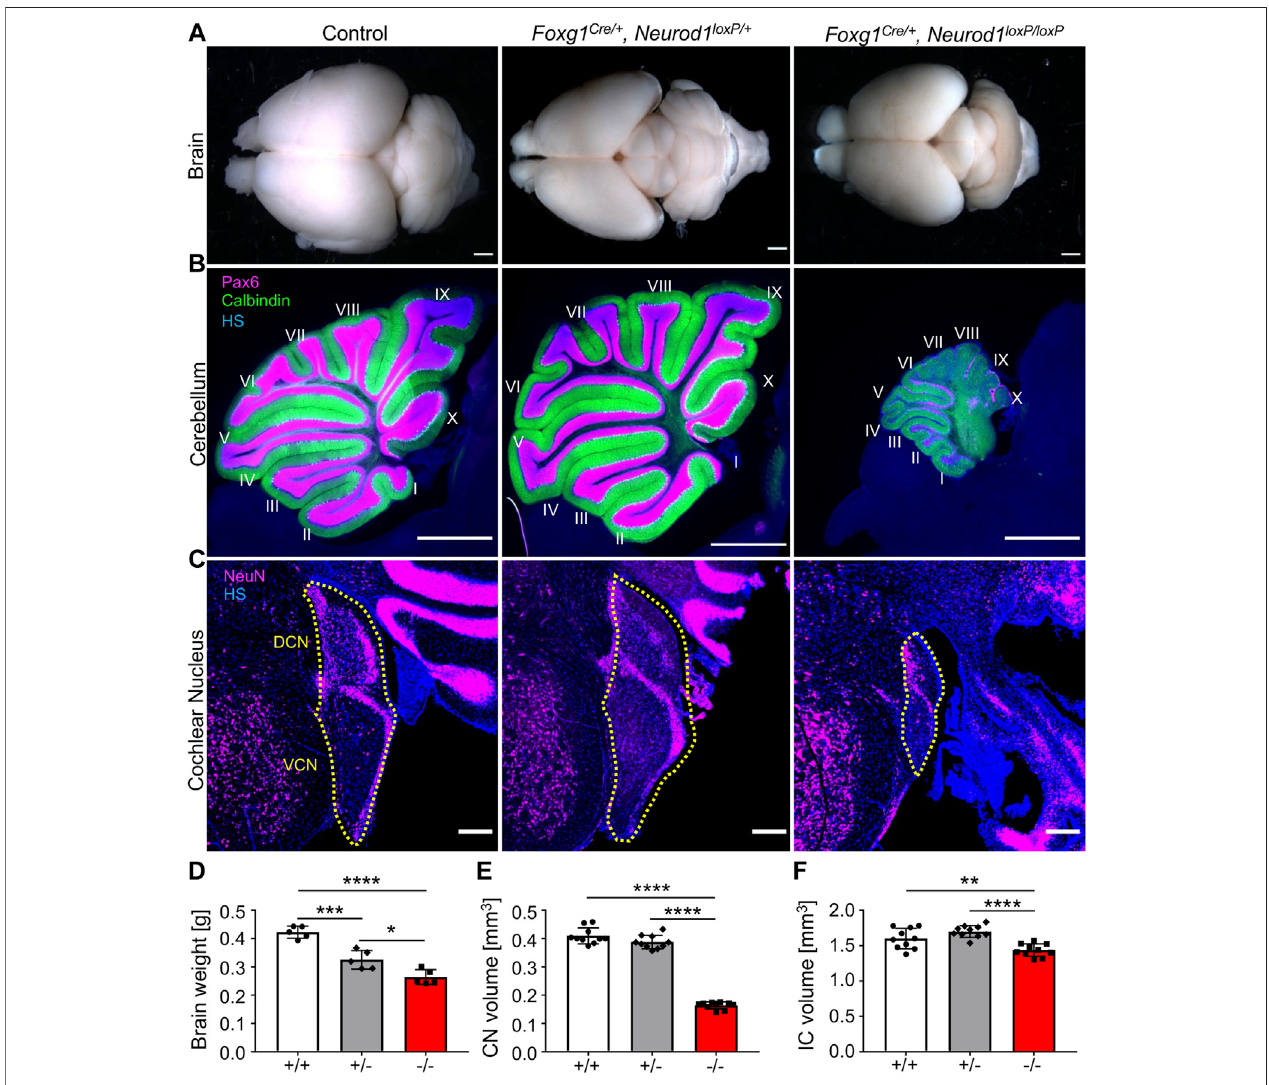
FIGURE 1 | Brain abnormalities are detected in Neurod1CKO mutants. (A , D) Adult brain size was reduced in Foxg1 Cre/+ , Neurod1 loxP/+ heterozygotes (+/ − ) and Foxg1 Cre/+ , Neurod1 loxP/loxP homozygous ( − / − ) mutants compared to controls. (B) The Neurod1CKO cerebellum was smaller with many Purkinje cells (Calbindin + ) but withfewergranulecells(Pax6 + ). (C , E , F) Thecochlearnucleus ’ ssizeandinferiorcolliculusweresigni fi cantlyreducedin Neurod1CKO mutantscomparedtocontrolsand heterozygotes. The dotted line indicates the boundaries of the cochlear nucleus. The values represent means ± SD, one-way ANOVA, * p ≤ 0.05, ** p ≤ 0.01, *** p ≤ 0.001,**** p ≤ 0.0001.Scalebars:1,000 µm (A , B) ;200 μ m (C) .CN,cochlearnucleus;DCN,dorsalcochlearnucleus;HS,Hoechstnuclearstaining;IC,inferiorcolliculus; VCN, ventral cochlear nucleus.